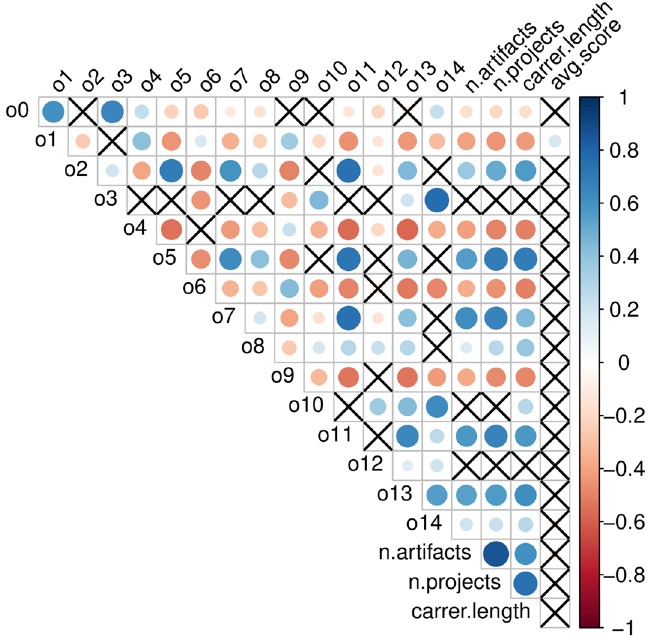
Figure 5. Correlation matrix for the NECTEC researchers network. Blue indicates positive correlation and red indicates negative correlation. Color intensity indicates the strength of correlation. Insignificant coefficients, according to p value p = 0.001 , are marked with a